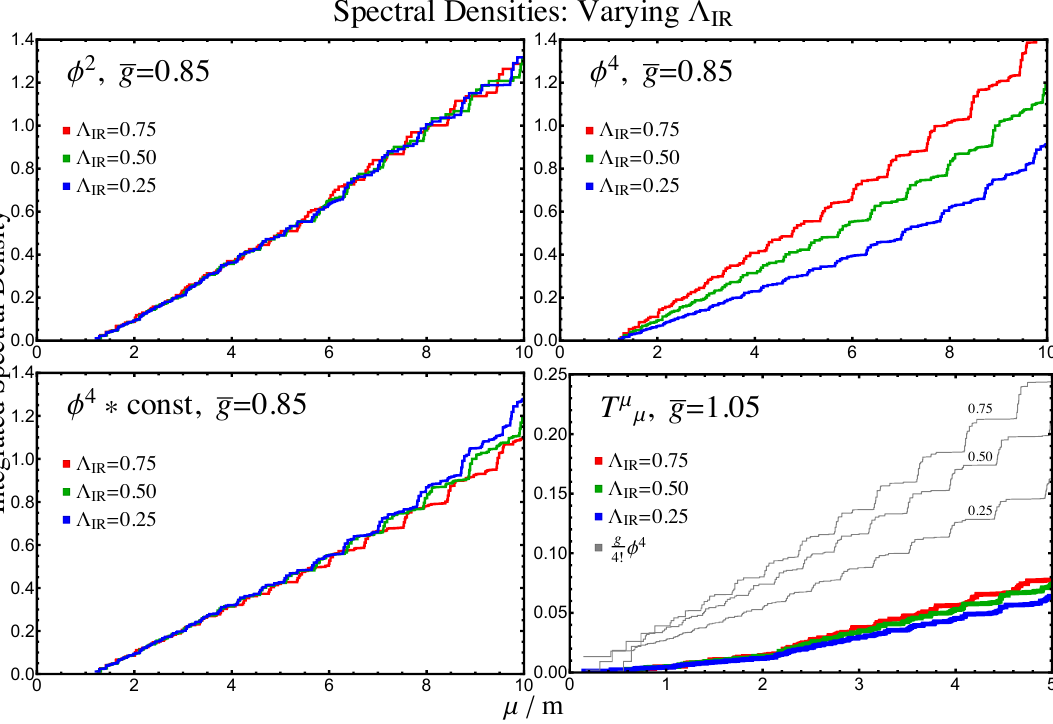
Figure 23 . Integrated spectral densities computed using different Λ IR at ∆ max = 16 (and ˆ c L = 1 ). At bottom left, we have rescaled the Λ